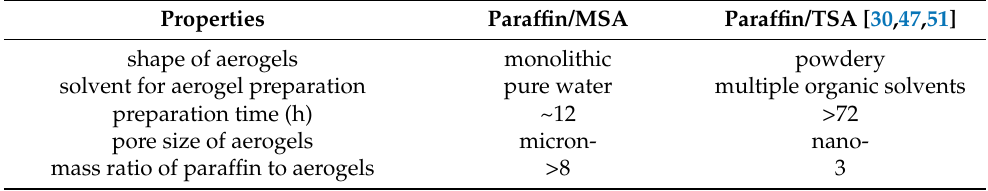
Table 3. Physical properties of two typical paraffin/silica aerogel phase-change composites. Properties Paraffin/MSA Paraffin/TSA [30,47,51] shape of aerogels monolithic powdery solvent for aerogel preparation pure water multiple organic solvents preparation time (h) ~12 >72 pore size of aerogels micron- nano- mass ratio of paraffin to aerogels >8